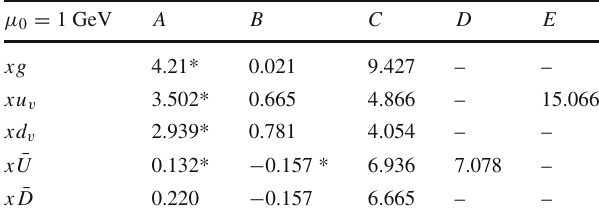
Table 3 Free parameters of the input parton distribution at the starting = 1 . 9Gev 2 using in the fit all data with Q 2 > 2GeV 2 and scale μ 2 F running of the coupling is changed ( μ 0 = 1GeV 2 ). Full diffractive corrections are included (1.4 MRW), there are no negative gluons (+) and the parameterization function is Ax B ( 1 − x ) C ( 1 + Dx + Ex 2 ) . The smaller value of B (as compared with B = 0 . 103 in Table 2) makes the gluons more flat. The parameters with an asterisk are not free since they are fixed by sum rules or the expected behaviour at low